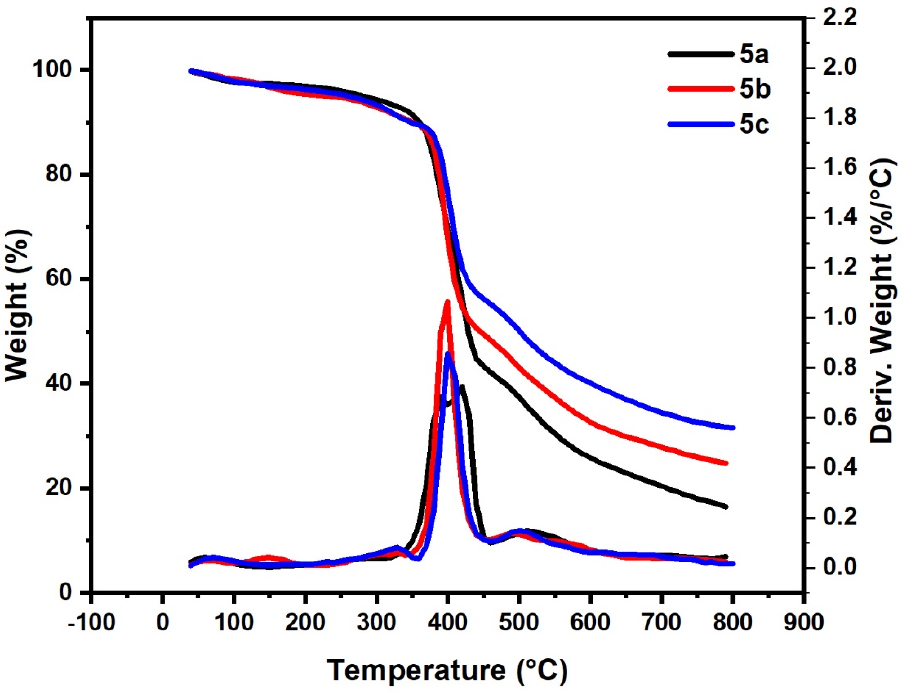
Figure 6. Thermogravimetric analysis of samples (5a-c).